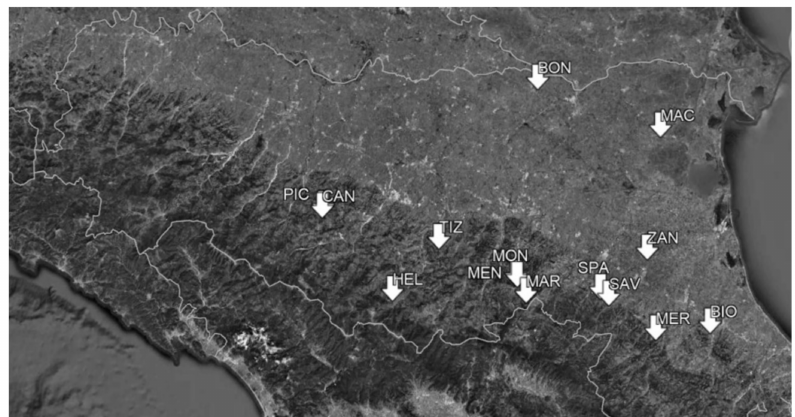
Figure 1. Geographical locations of the study sites.